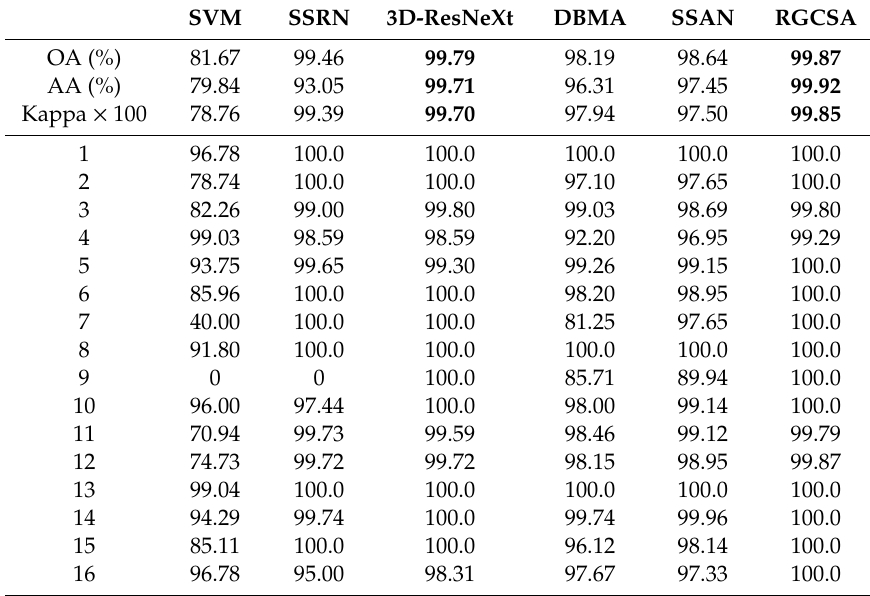
Table 11. Classification results of di ff erent methods for the IN dataset.